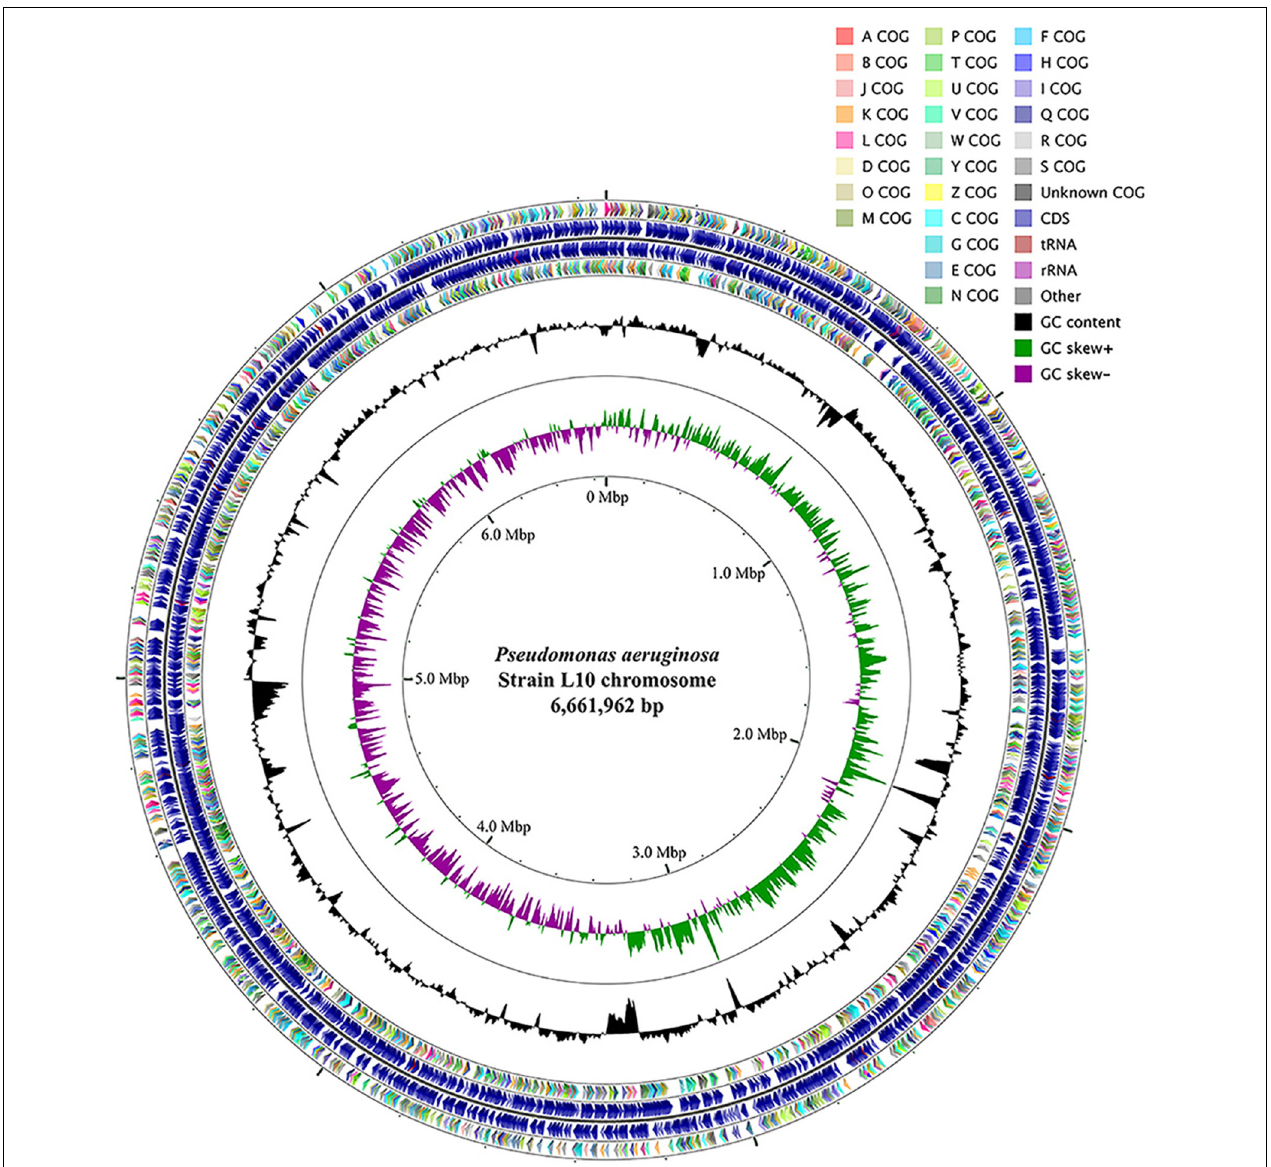
FIGURE 5 | Circular genome map of P. aeruginosa L10. From outside to center, ring 1 and 4 show protein-coding genes oriented in the forward (colored by COG categories) and reverse (colored by COG categories) directions, respectively. ring 2 and 3 denote genes on forward/reverse strand; ring 5 shows G + C% content plot, and the inner-most ring shows GC skew, purple indicating negative values and olive, positive values. The circular map was generated with GCViewer (https://github.com/chewiebug/GCViewer, last accessed January